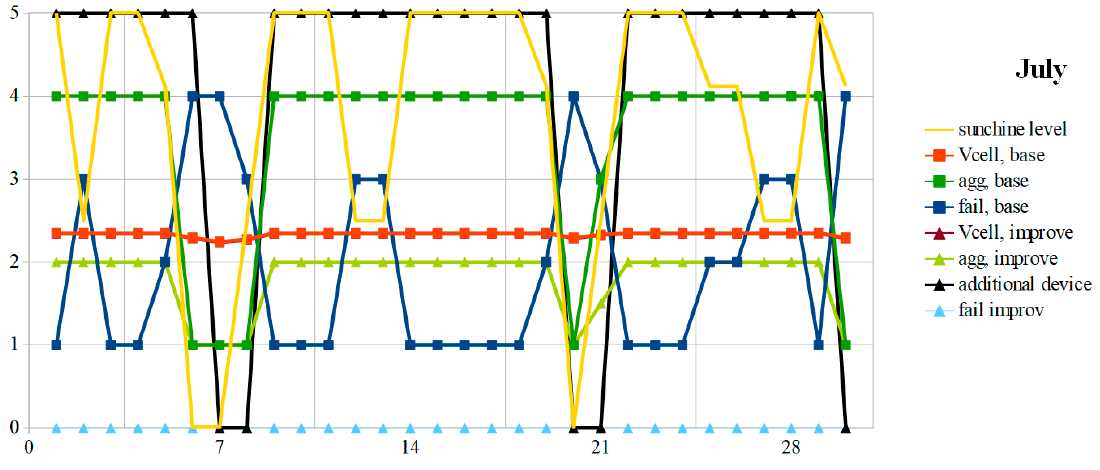
Figure 9. Same curves, in July.